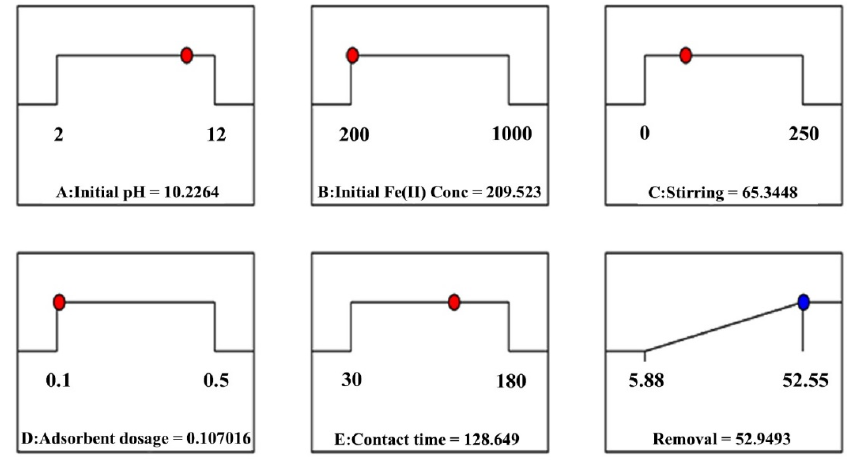
Fig. 5. Ramps solutions for optimising the five selected